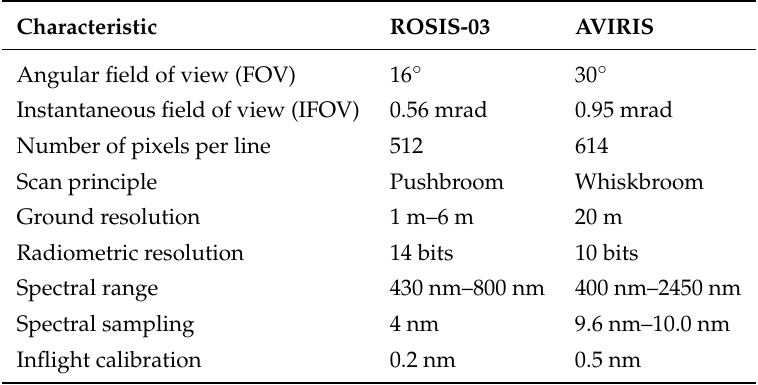
Table 1. Main characteristics for both ROSIS-03 and AVIRIS